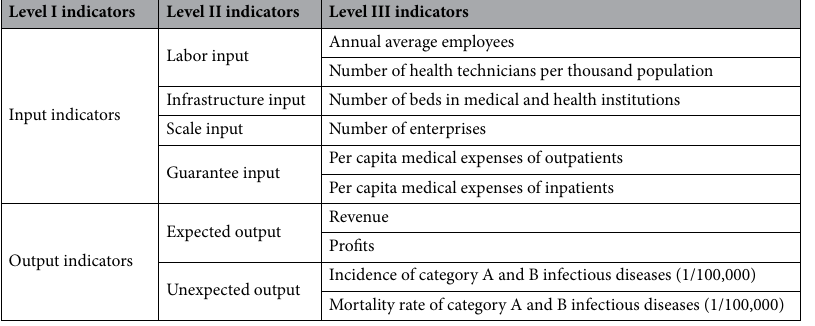
Table 2. Input–output index